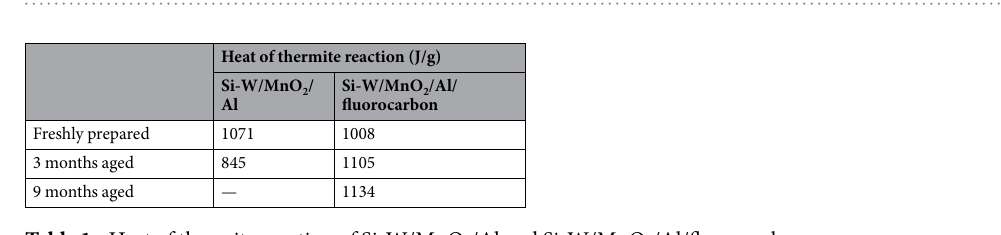
Table 1. Heat of thermite reaction of Si-W/MnO 2 /Al and Si-W/MnO 2